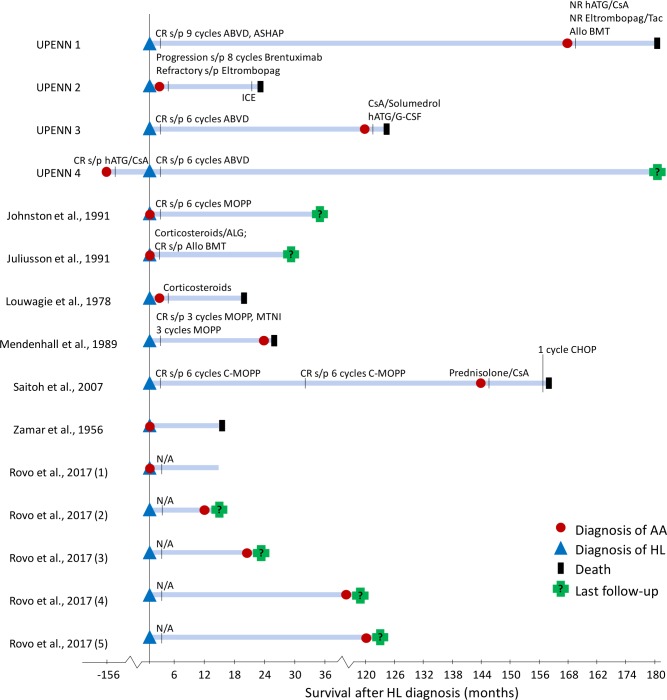
Clinical Course of patients with Hodgkin Lymphoma and Aplastic Anemia.A schematic diagram demonstrating the clinical course of 15 patients with diagnoses of HL and AA. Patient reported by Brusamolino et al. is not shown because of incomplete clinical information. Blue triangle, HL diagnosis; red circle, AA diagnosis; black triangle, death; green cross, last follow-up. Treatments for HL and AA are denoted by black vertical lines, with treatment and response listed above the respective line. HL, Hodgkin Lymphoma; AA, Idiopathic Acquired Aplastic Anemia; ABVD, Doxorubicin, Bleomycin, Vinblastine, Dacarbazine; ASHAP, Doxorubicin, Solumedrol, Cytarabine, Cisplatin; MOPP, Mechlorethamine, Vincristine, Procarbazine, Prednisone; MTNI, Modified Total Nodal Irradiation; C-MOPP, Cyclophosphamide, Vincristine, Procarbazine, Prednisone; CHOP, Cyclophosphamide, Doxorubicin, Vincristine, Prednisone; Allo BMT, Allogenic Bone Marrow Transplant; hATG, Horse Antithymocyte Globulin; ATG, Antithymocyte Globulin; ALG, Antilymphocyte Globulin, CsA, Cyclosporine A; Tac, Tacrolimus; G-CSF, Granulocyte Colony Stimulating Factor; CR, Complete Response; PR, Partial Response; NR, No Response.